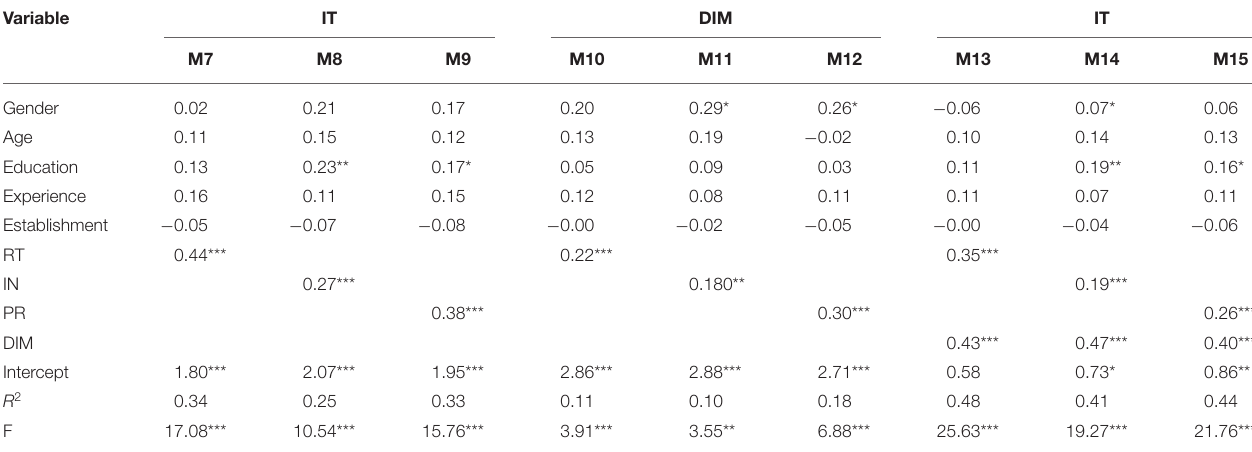
TABLE 4 | The mediation effect test of defensive impression management strategies. Variable